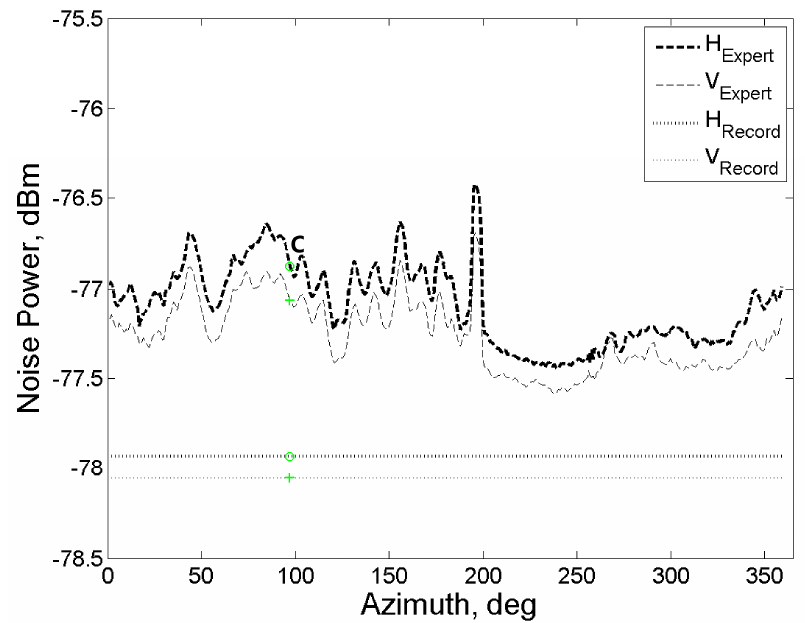
Figure 7. Noise power for PPI scan data showed in Figure 5 resulting from H and V channels. Radial C is marked. Subscript “Expert” means that noise power is estimated by the expert method and